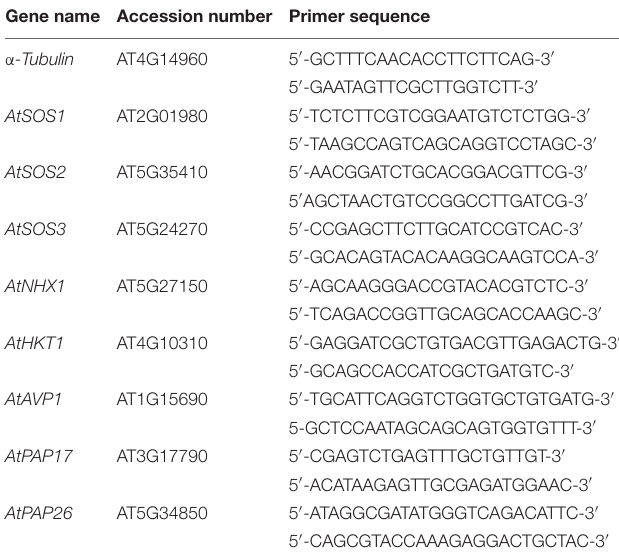
TABLE 1 | The sequences of each primer pair used to